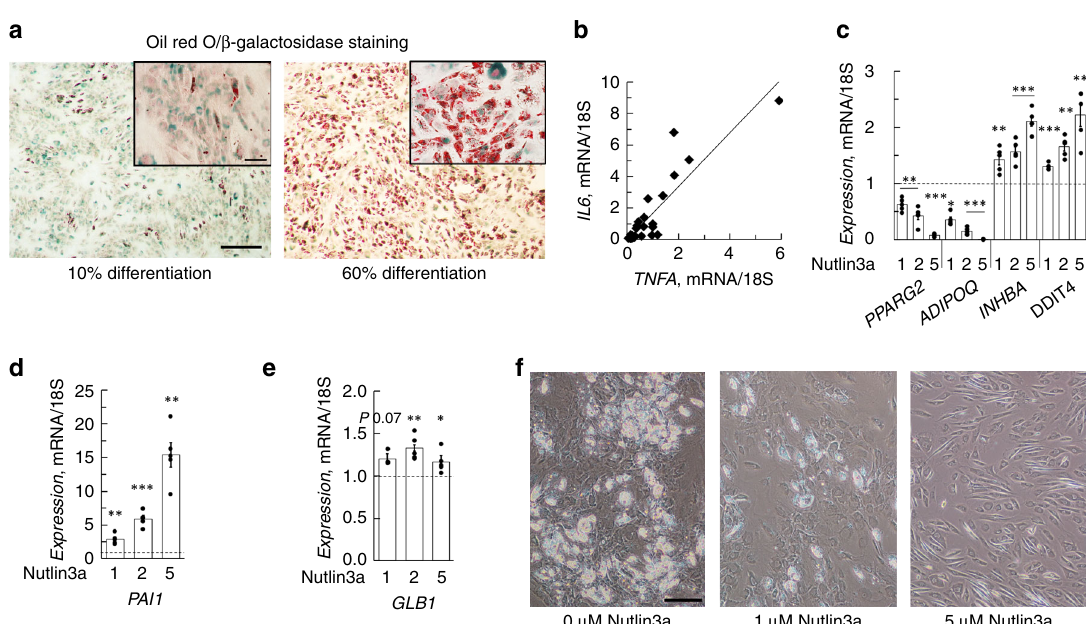
Fig. 5 Cell senescence induces proin fl ammatory signals and reduces lipid accumulation. a Double staining of differentiated SVF cells with ORO and β - galactosidase. Result from two individuals with different degree of differentiation. Scale bar 200 µ m. b TNFA vs. IL6 in whole adipose tissue, P < 0.001, n = 28 biological independent samples. Comparisons were made with Spearman ’ s correlation coef fi cient. mRNA expression was fi rst normalized to 18 S and then normalized to expression in undifferentiated sample ( = 1). c – f Nutlin3a, inhibitor of p53 degradation, was added to the differentiation cocktail at time 0 h and was present throughout differentiation. Expression of adipogenic and senescence markers. Differentiation for 3 days ( c – e ) and 12 days ( f ). Results from fi ve independent experiments, means± SEM. f Images from differentiation day 10 of the cells in fi gure ( e ). Scale bar 100 µ m. c – f Comparisons were made with Spearman ’ s correlation coef fi cient. * P < 0.05, ** P < 0.01, and *** P <